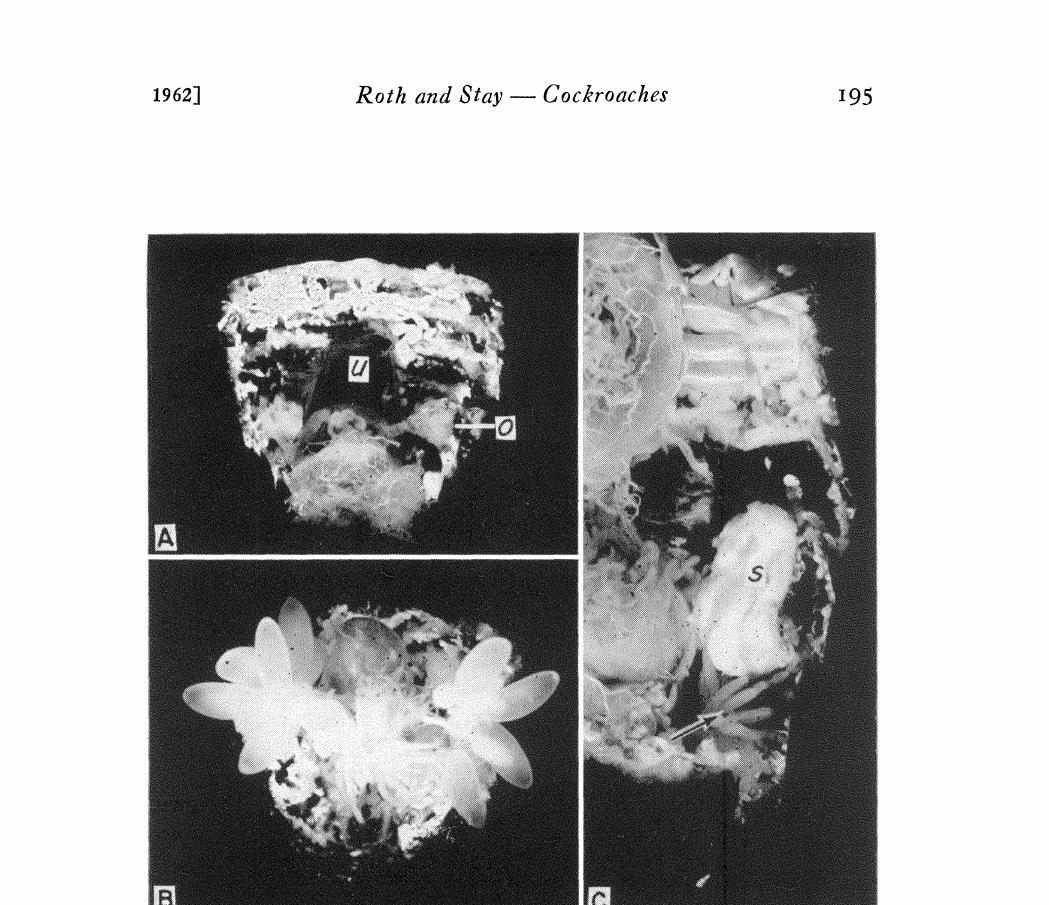
Fig. 13A-B. Pycnoscelus surinamensis (parthenogenetic strain). A. Ovaries (0) undeveloped as the result of the presence of a wax "o/Stheea" in the uterus (u). The o/Stheea was removed on the thirteenth day of pregnancy, and replaced with wax. The female was dissected 37 days later. B. O/Seytes which developed in a female that had a wax "o/Stheea" in its uterus for 37 days. The o/Stheea was removed 13 days after ovulation and replaced by wax. Twenty-four days later the nerve cord was severed and the female was dissected 13 days later. Fig. 13C. LeucoIhaca maderae. Dissection of a female that mated after her nerve cord had been transeeted. The spermatophore (s) was inserted by the male into the body cavity near the right ovary